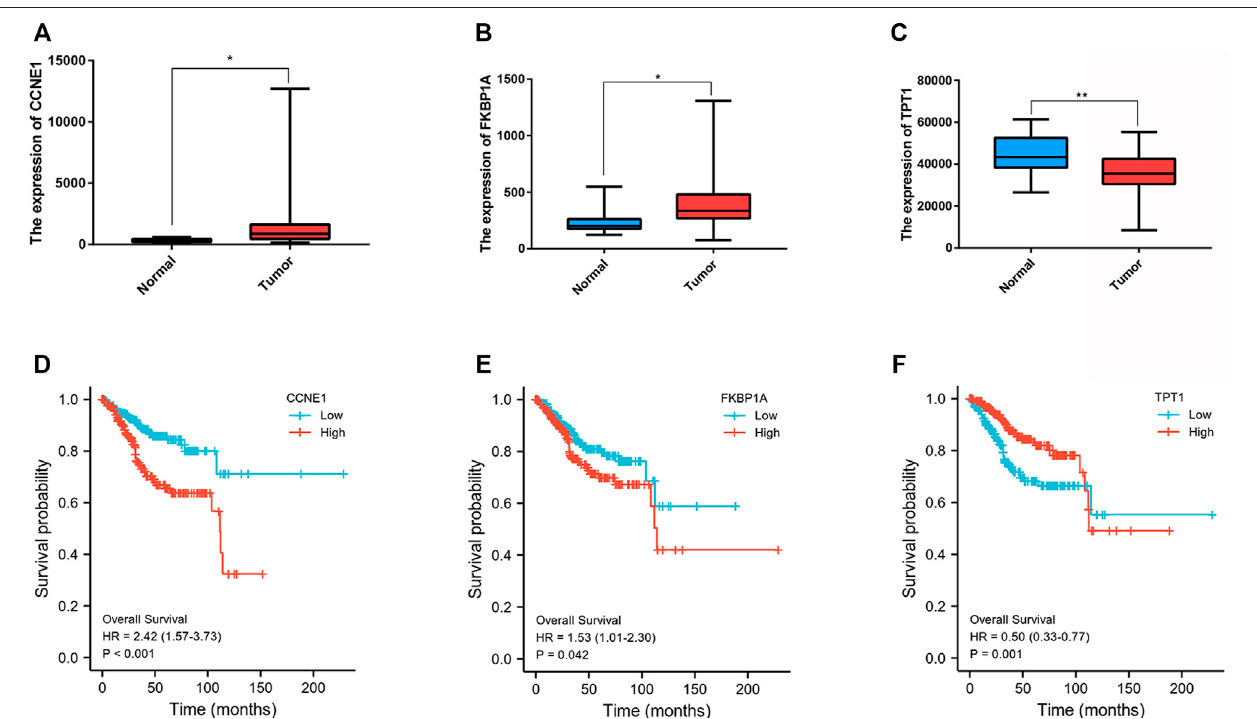
FIGURE 9 | Expression and survival analysis of three MiRNA target genes. (A) Box plot of the differentially expressed MiRNA target genes (CCNE1) between the normal (blue) and the tumor tissues (red) in GEO database. (B) Box plot of the differentially expressed MiRNA target genes (FKBP1A) between the normal (blue) and the tumortissues(red)inGEOdatabase. (C) BoxplotofthedifferentiallyexpressedMiRNAtargetgenes(TPT1)betweenthenormal(blue)andthetumortissues(red)inGEO database. (D) Kaplan – Meier curves of the OS for CCNE1 in GEO database. (E) Kaplan – Meier curves of the OS for FKBP1A in GEO database. (F) Kaplan – Meier curves of the OS for TPT1in GEO database. * p < 0.05; ** p <